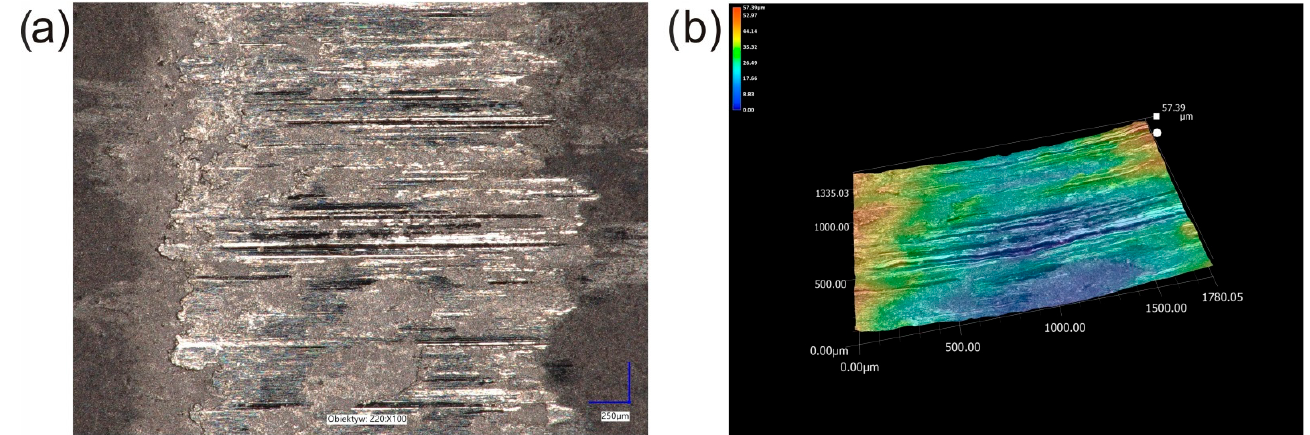
Figure 18. The surface morphology of the counter-specimen mating with the specimen laser-alloyed with a laser beam power of 1.3 kW: ( a ) image recorded by the digital microscope, ( b ) 3D image of the surface topography.